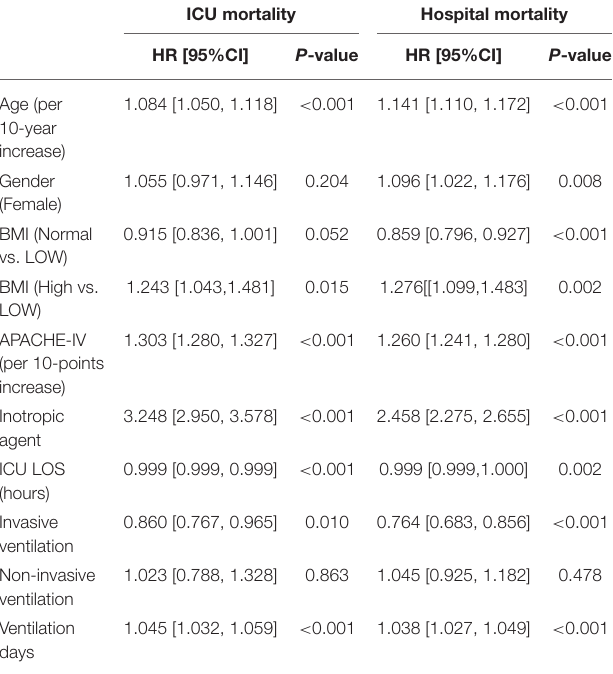
TABLE 2 | Regression analysis was performed to investigate the risk factors of ICU mortality and hospital mortality for cardiogenic shock patients. ICU mortality